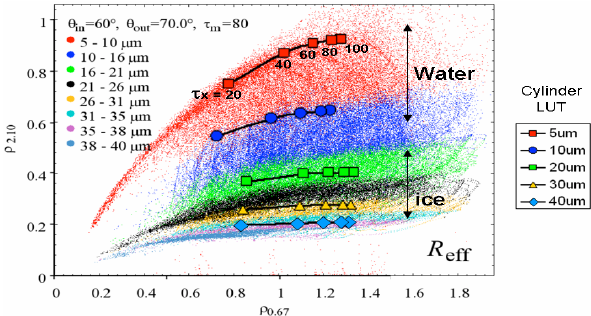
Fig. 5. The collection of colored dots in the background repre- sent the 3-D analog of the plane parallel Nakajima-King type of diagrams for stochastic cloud fields and a variable vertical profile of droplet effective radii, and thermodynamic phase. The overlaid black lines and markers were calculated by individual homogeneous cloud cylinders with total τ z = 100, effective radius as shown in the legend, and optical distance aspect ratios of 5, 4, 3, 2, and 1. A com- bination of ice and water particles were used in both simulations for the cylindrical and for the stochastic cloud